Question: What type of chart is this?
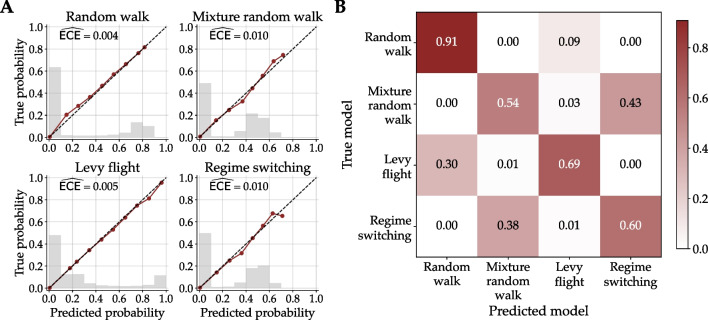
Answer: heatmap